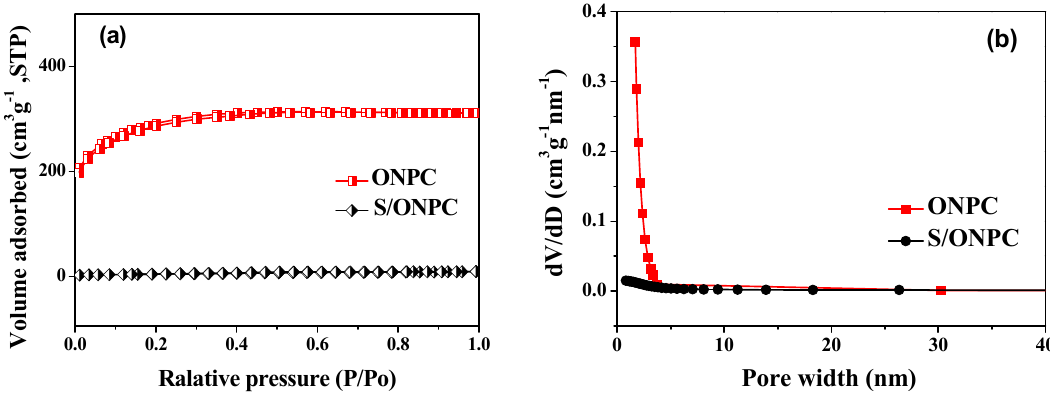
Figure 1. Nitrogen adsorption/desorption isotherms ( a ) and size distribution ( b ) of the ONPC and S/ONPC composite. Table 1. BET results (surface area and pore volume) for the ONPC and